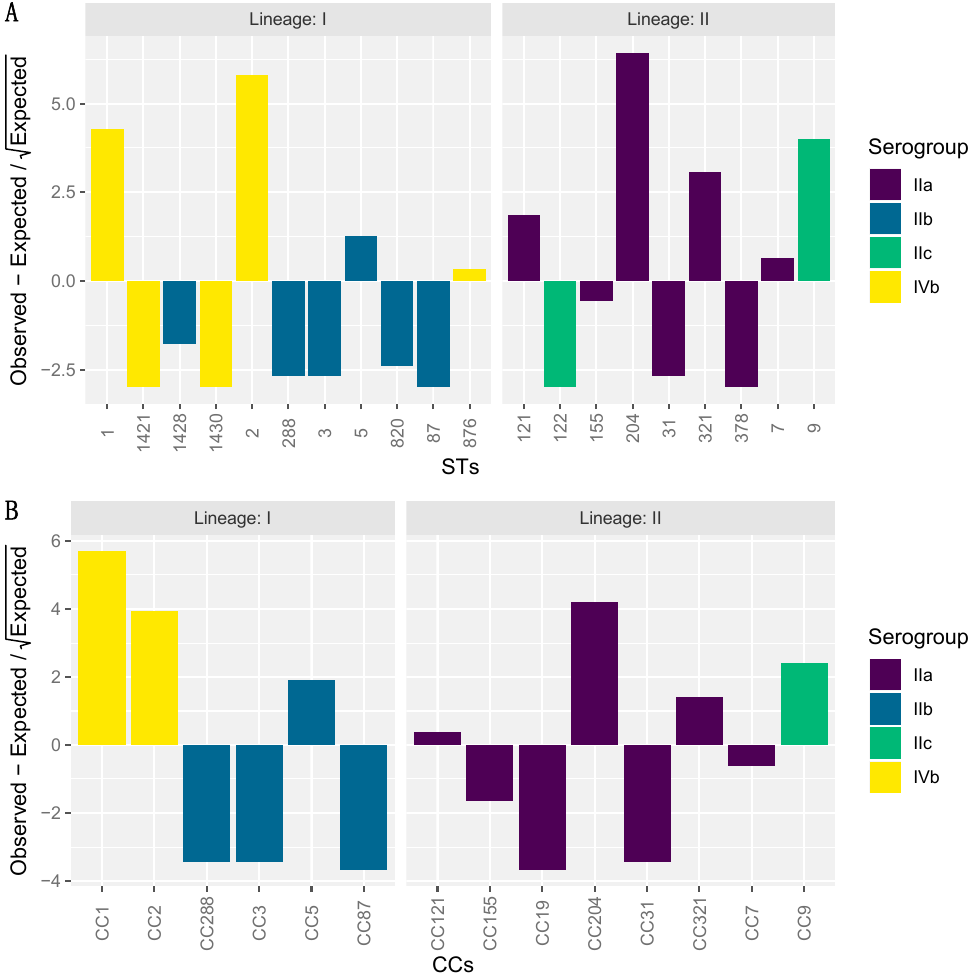
Figure 2. Hanging chi-gram indicating the deviation from expected occurrence across the Listeria monocytogenes isolates: ( A ) Sequence type; ( B ) clonal complex .